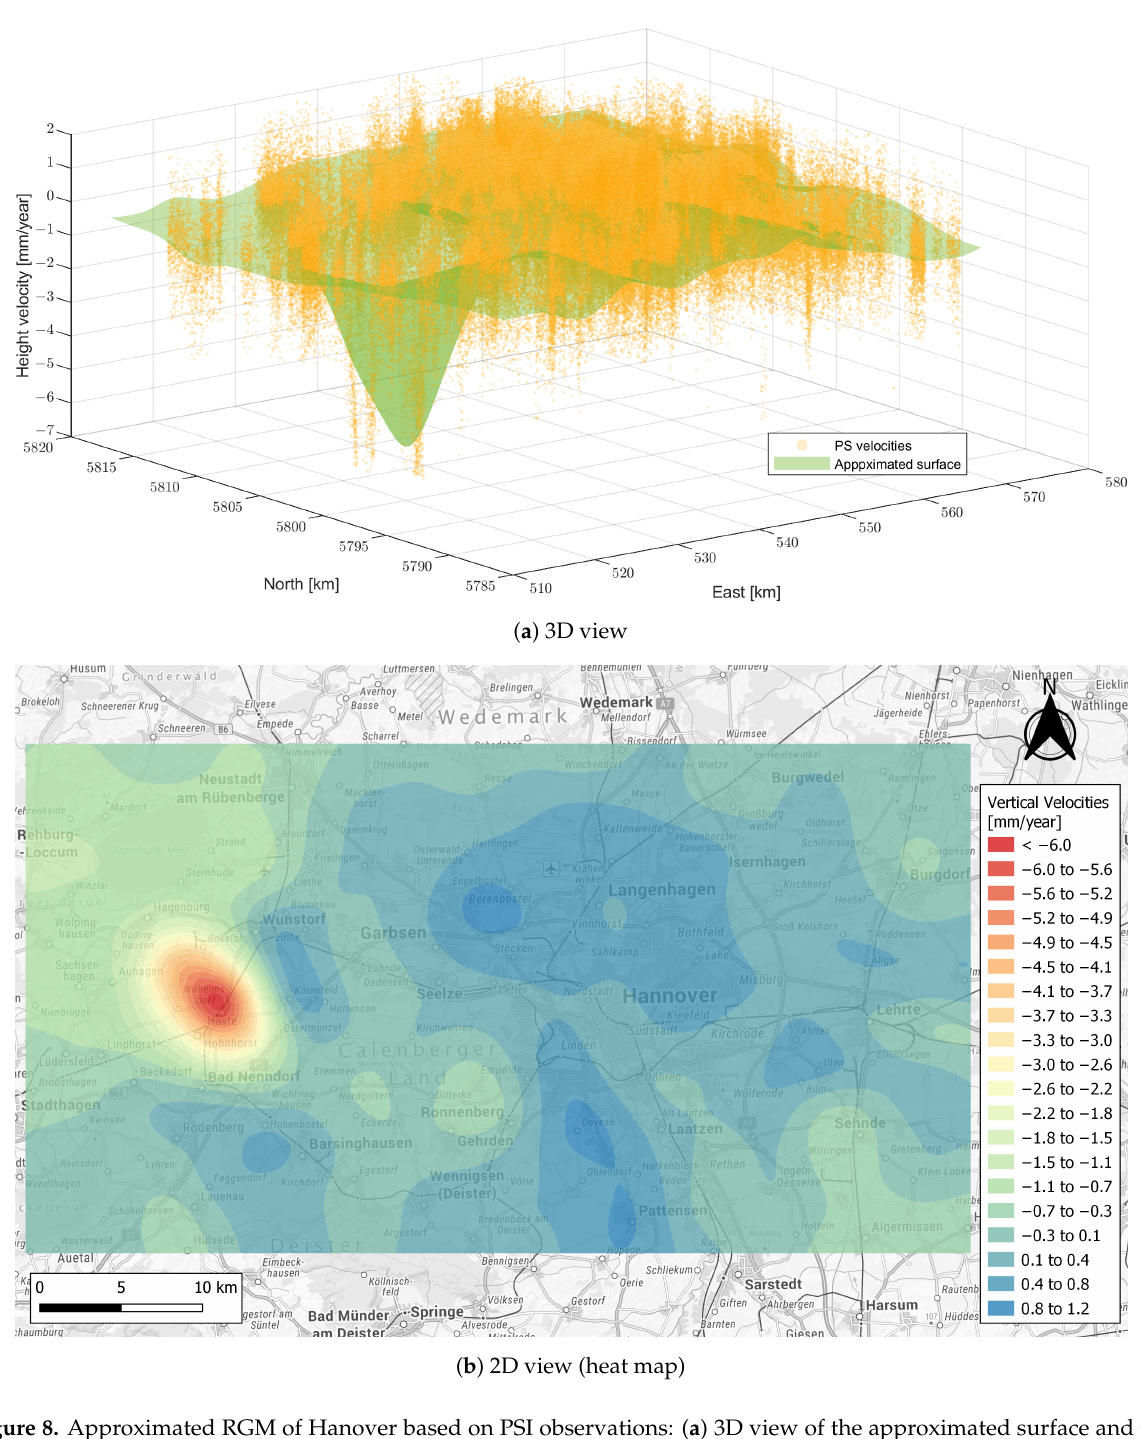
Figure 8. Approximated RGM of Hanover based on PSI observations: ( a ) 3D view of the approximated surface and the observations, ( b ) heat map of the